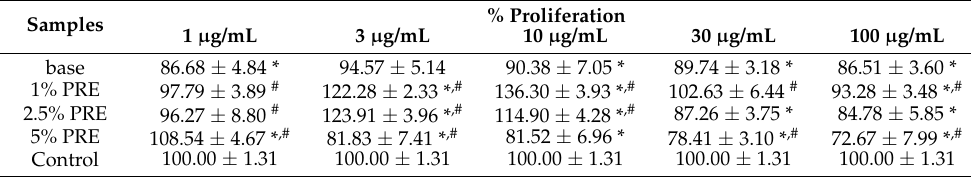
Table 6. Effect of the microemulsion base and microemulsions containing PRE at various concentra- tions on HDF cell proliferation.